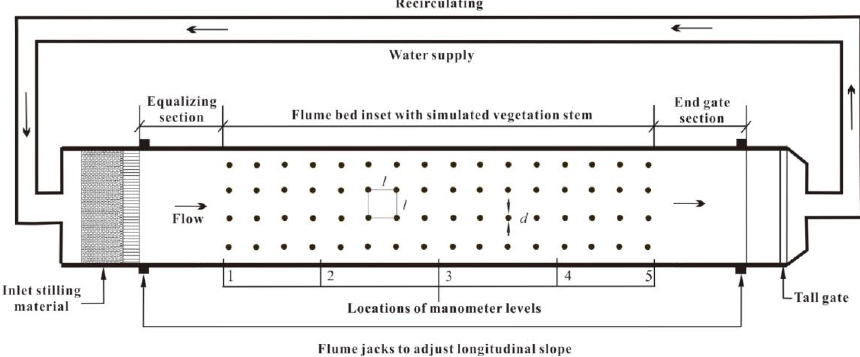
Figure 1. Experimental setup to measure the hydraulic parameters.